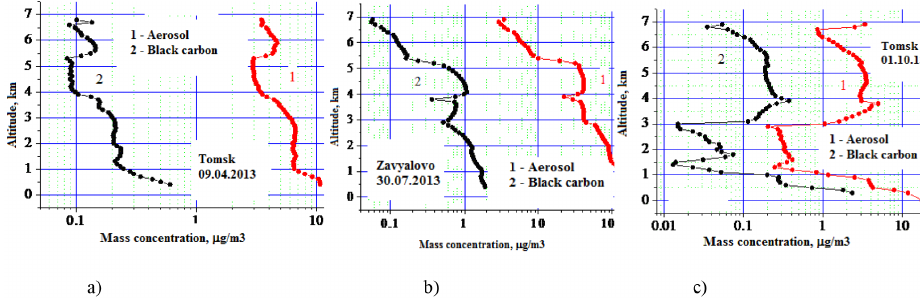
Figure 5. Vertical aerosol and black carbon profiles from flying laboratory data in the Tomsk region for (a) 9 April (near Tomsk and Zavyalovo settlement, south of Novosibirsk region), (b) 30 July (Zavyalovo settlement), and (c) 1 October 2013 (Tomsk and Zavyalovo settlement).